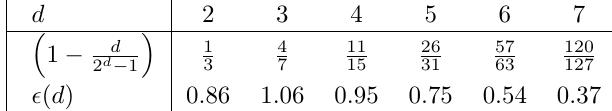
Table 2: Coefficients for estimating the affine span